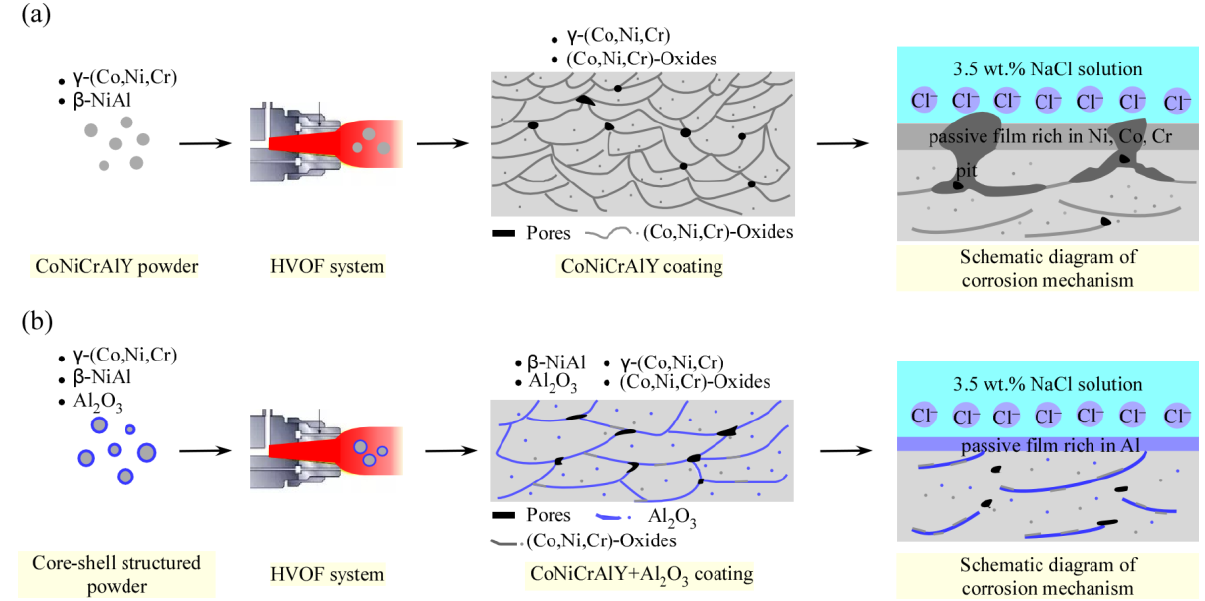
Figure 7. Schematic diagram of microstructure evolution and corrosion mechanism of the CoNiCrAlY coating ( a ) and CoNiCrAlY-Al 2 O 3 coating ( b ).